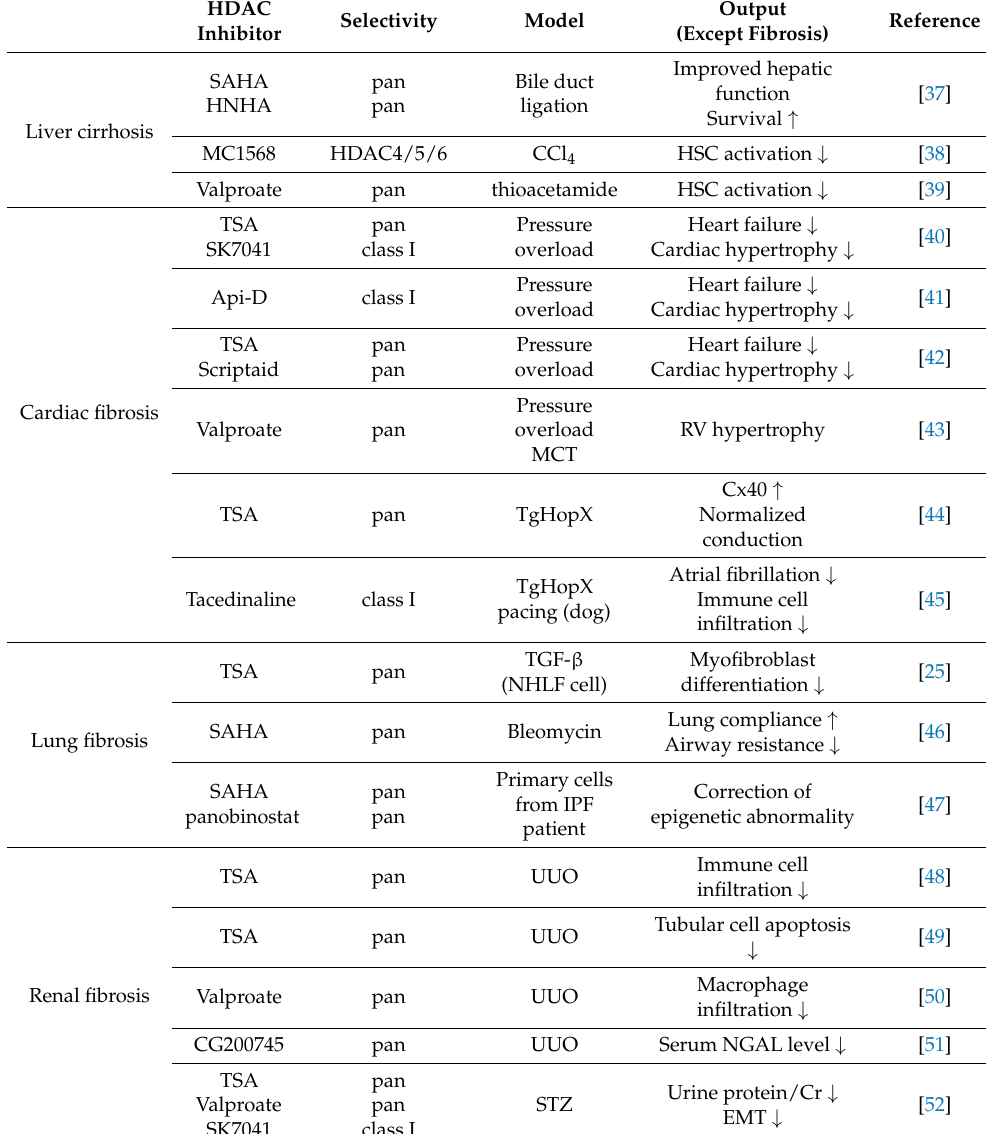
Table 1. HDACIs tested in animal or cellular studies for human fibrosis-associated